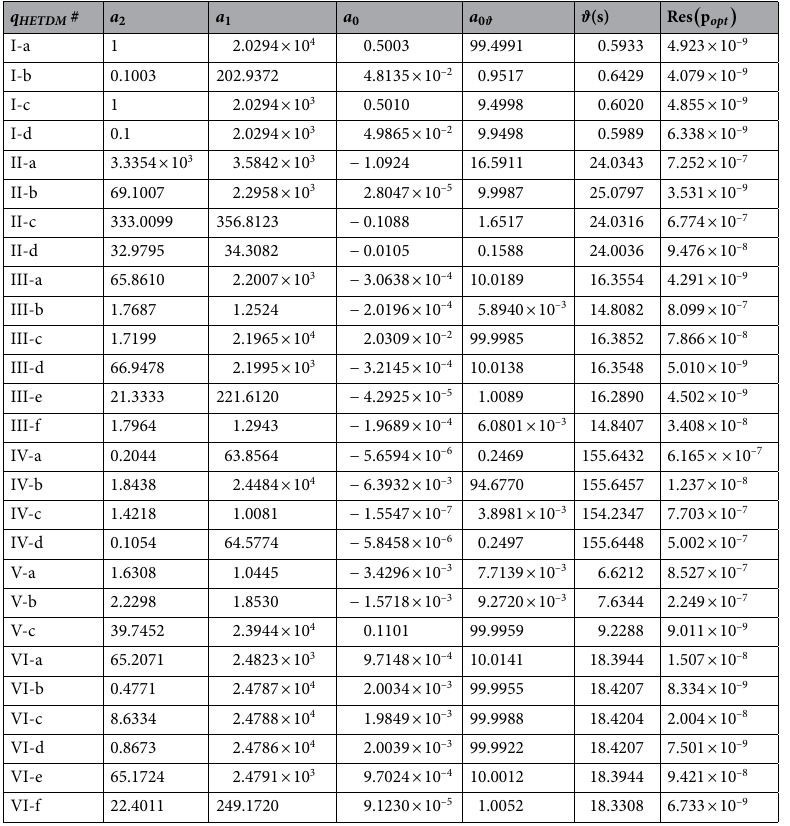
Table 5. HETDM characteristic RQP parameters after pole